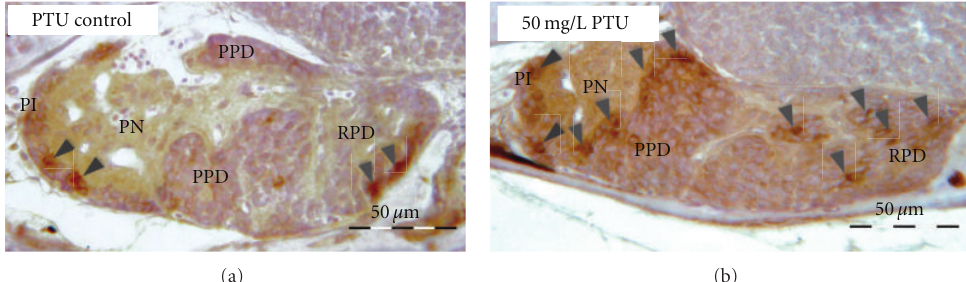
Figure 10: Sagittal sections of immunohistochemically stained zebrafish ( Danio rerio ) pituitaries exposed to 0 and 50 mg/L PTU. The samples show clear proliferations of TSH-producing cells ( (cid:2) ) especially in the proximal pars distalis . Sections of 2 μ m thickness immunostained with an anti-TSH antibody (nuclei were counterstained with Mayer’s hematoxylin). PI— pars intermedia (adenohypophysis); PN— pars nervosa (neurohypophysis); PPD—proximal pars distalis (adenohypophysis); RPD—rostral pars distalis (adenohypophysis).